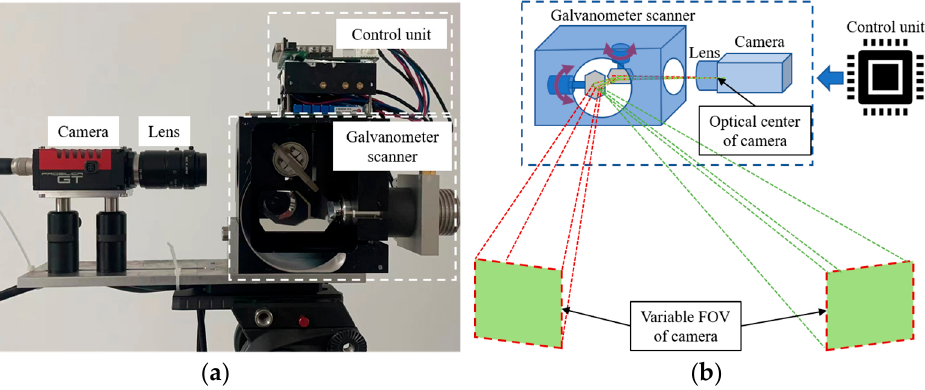
Figure 1. Diagram of the VMOS. ( a ) Configuration of the VMOS. ( b ) The schematic of the VMOS adjusting the boresight and FOV of the camera.